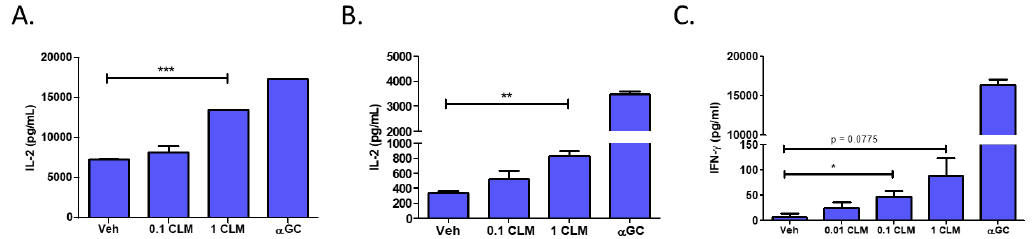
Figure 6. Treatment with cardiolipin enhances NKT activation. L-CD1d cells were pulsed with a mixture of cardiolipin species (CLM) for 4 h at 37 ◦ C prior to co-culture with ( A ) DN32.D3 or ( B ) N38-3C3 for 24 h. IL-2 production was measured by ELISA. ( C ) Mouse splenocytes were pulsed with CLM for 4 h at 37 ◦ C prior to co-culture with mouse liver mononuclear cells (MNCs) for 48 h. IFN- γ levels in the supernatant was then measured by ELISA. Each ELISA was conducted in triplicate. Data was analyzed using a student’s t -test. * p < 0.05; ** p < 0.005; *** p < 0.0001.